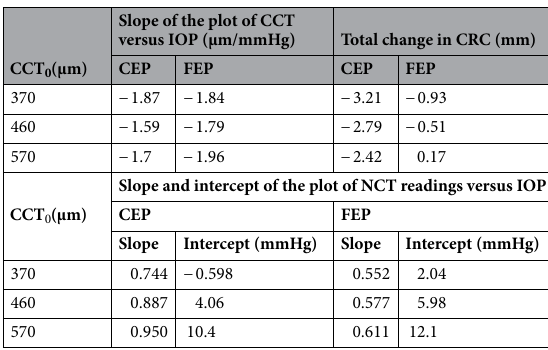
Table 1. A comparison of the overall changes in central corneal thickness (CCT) and cornea radius curvature (CRC) and the difference in non-contact tonometer (NCT) readings according to the initial CCT and the types of eye phantoms. IOP intraocular pressure, CEP cornea eye phantom, FEP full eyeball phantom, CCT 0 CCT under zero IOP.